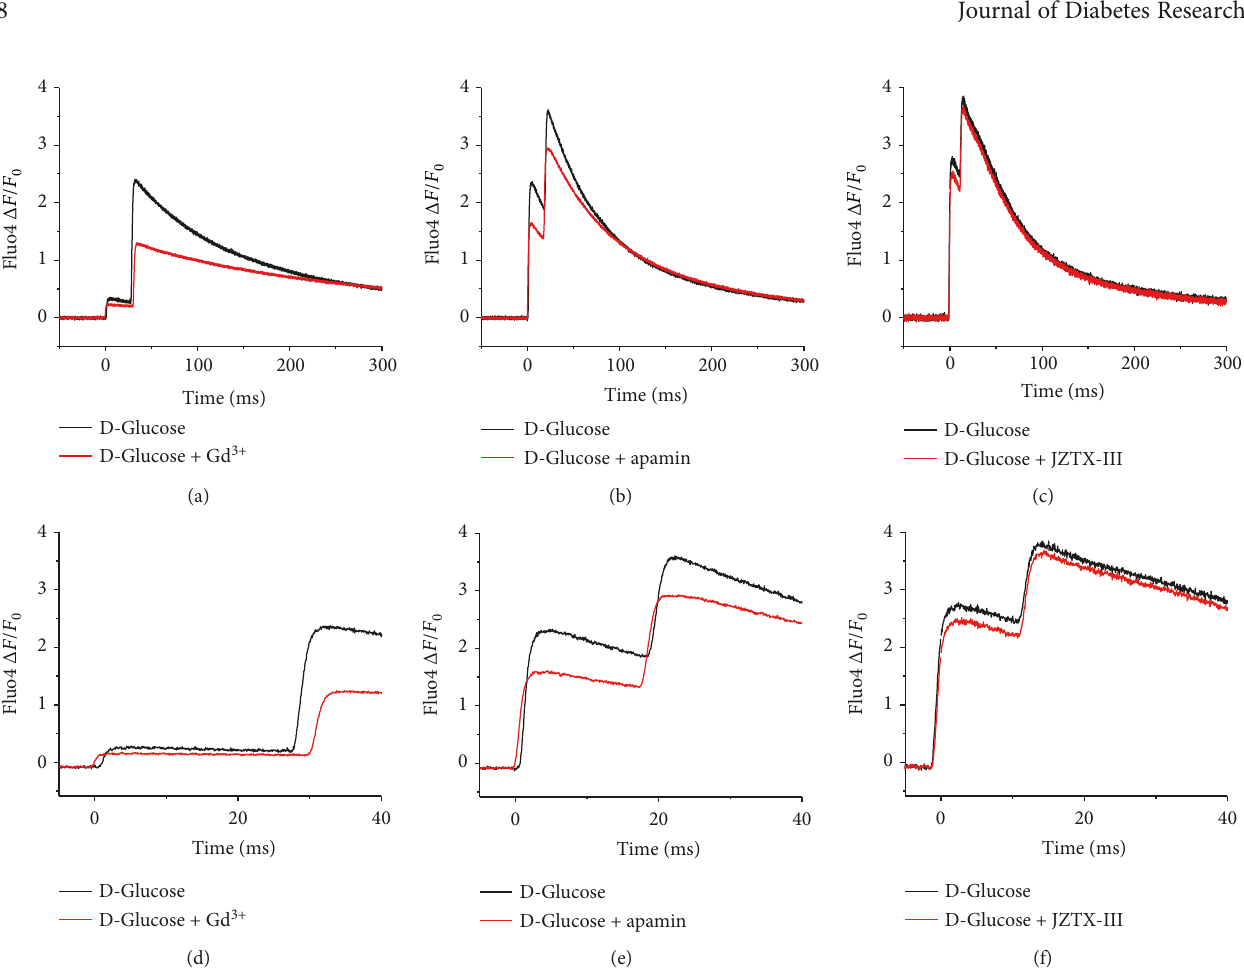
Figure 4: Inhibition of ion channels known to modulate the excitable properties of skeletal muscle: impact on biphasic AP-transients on 5-day old cultured fi bers challenged with elevated glucose. Representative time course of a biphasic AP-induced Ca 2+ transient (left panels) measured in fi bers challenged with elevated D-glucose (25 mM; 48h.) before (black traces) and 10 minutes after (red traces) the treatment with gadolinium (100 μ M) (a), apamin (1 μ M) (b), and JZTX-III (1 μ M) (c). Panels (d – f) are zoomed-in versions of the records shown in (a – c) to better appreciate biphasic responses before and after channel blockers addition. No signi fi cant changes in time course of the Ca 2+ transient (i.e., interspike interval) were found in fi bers challenged with 25 mM D-glucose-exposed fi bers and treated with gadolinium ( n = 8 fi bers; p > 0 05 , two-sample paired Student ’ s t -test), apamin ( n = 8 fi bers; p > 0 05 , two-sample paired Student ’ s t -test), or JZTX-III ( n = 6 fi bers; p > 0 05 , two-sample paired Student ’ s t -test), when compared to fi bers challenged with